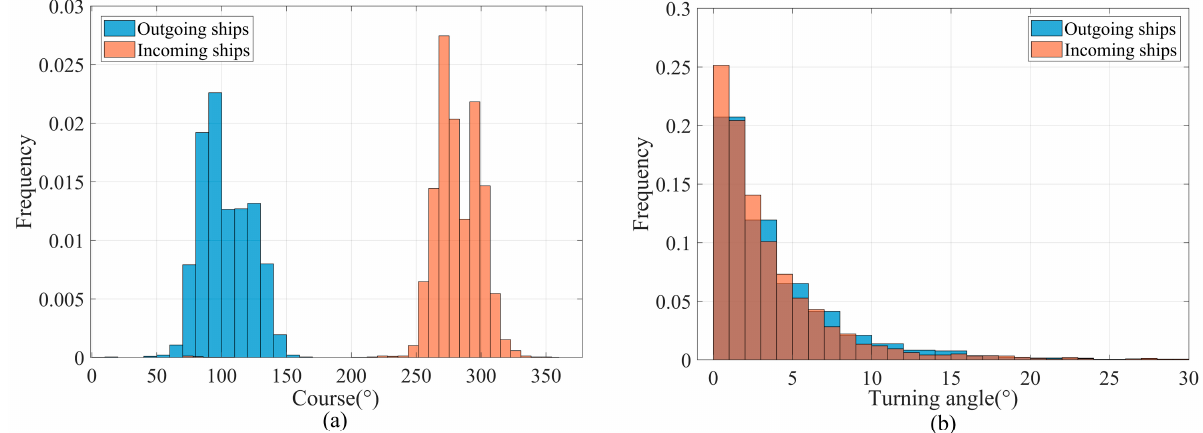
Figure 20. Turning angle statistics of outgoing and incoming ships. ( a ) Histogram of navigation course statistics; ( b ) histogram of course difference of adjacent data. course statistics; ( b ) histogram of course difference of adjacent data.